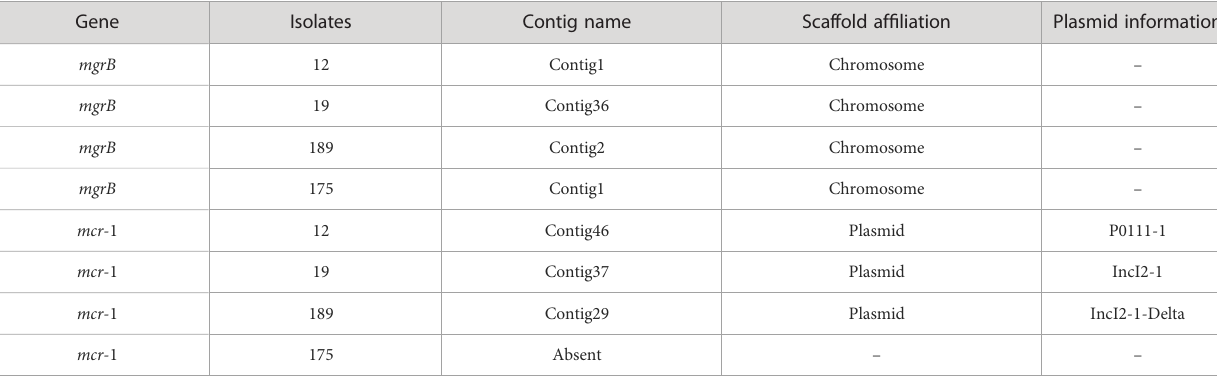
TABLE 5 mgrB and mcr genes in polymyxin-resistant E. coli